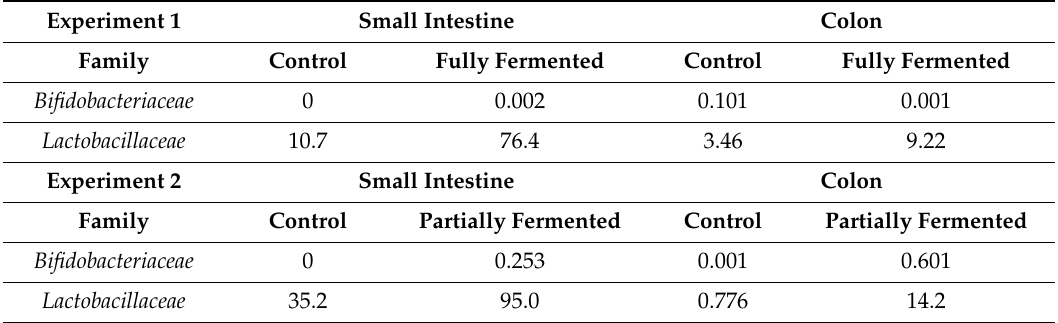
Table 4. Relative abundance (%) of the bacterial families Bifidobacteriaceae and Lactobacillaceae depending on the dietary treatment and sampling point in Experiment 1 and Experiment